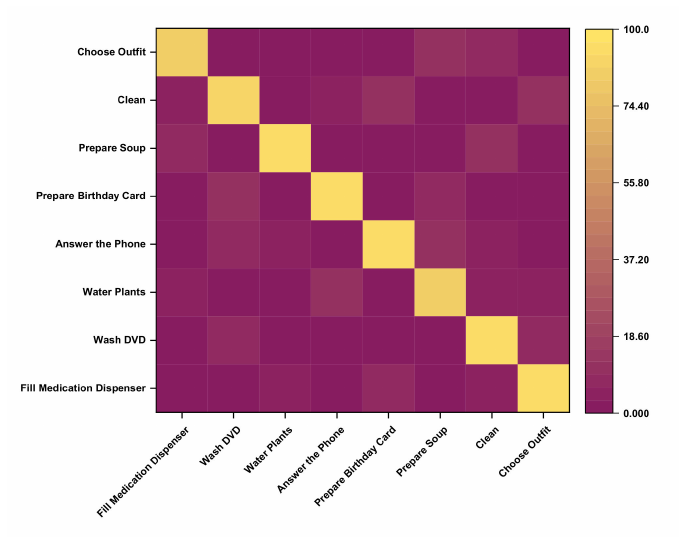
Figure 10. Confusion matrix for Kyoto 3.